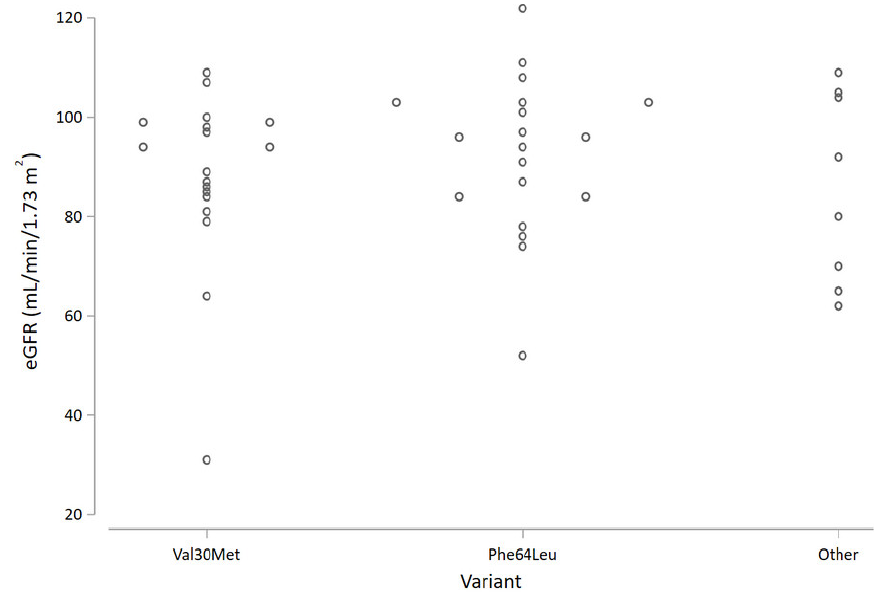
Figure 1. Strip plot of eGFR by variant.